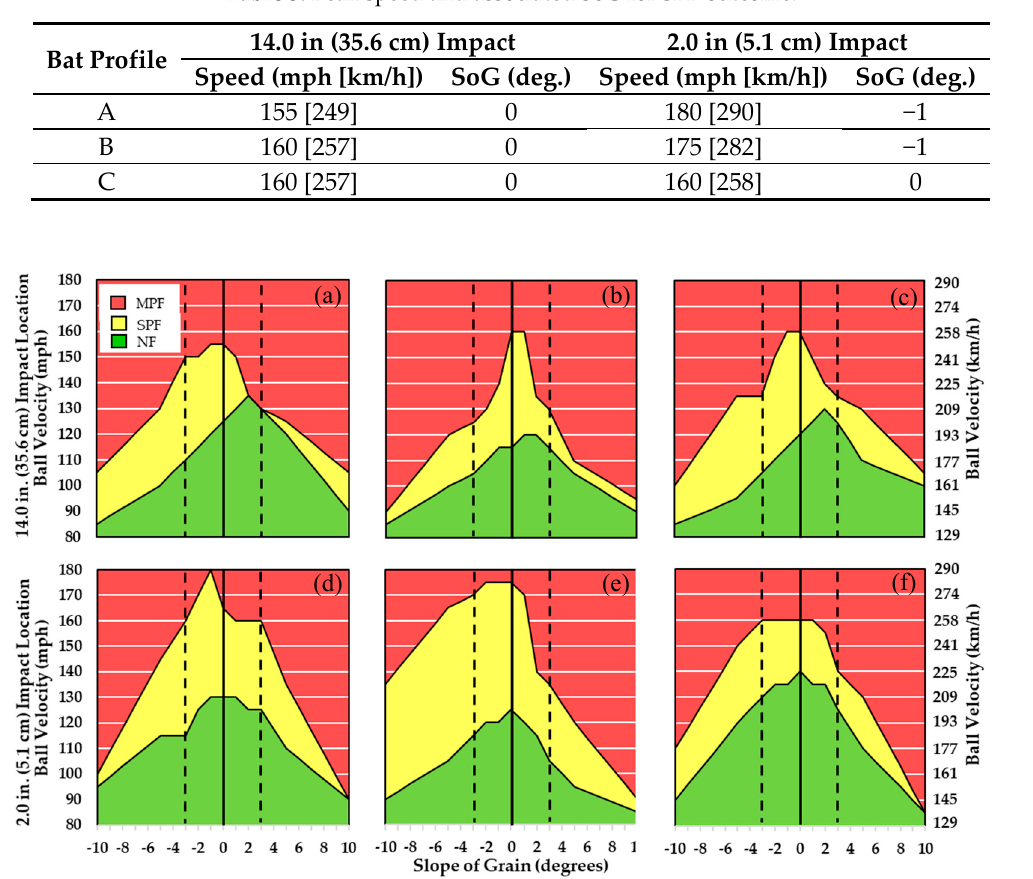
Figure 4. Top row, left to right—14.0 in. (35.6 cm) impact models for ( a ) Profile A, ( b ) Profile B, and ( c ) Profile C. Bottom row, left to right—2.0 in. (5.1 cm) impact models for ( d ) Profile A, ( e ) Profile B, and ( f ) Profile